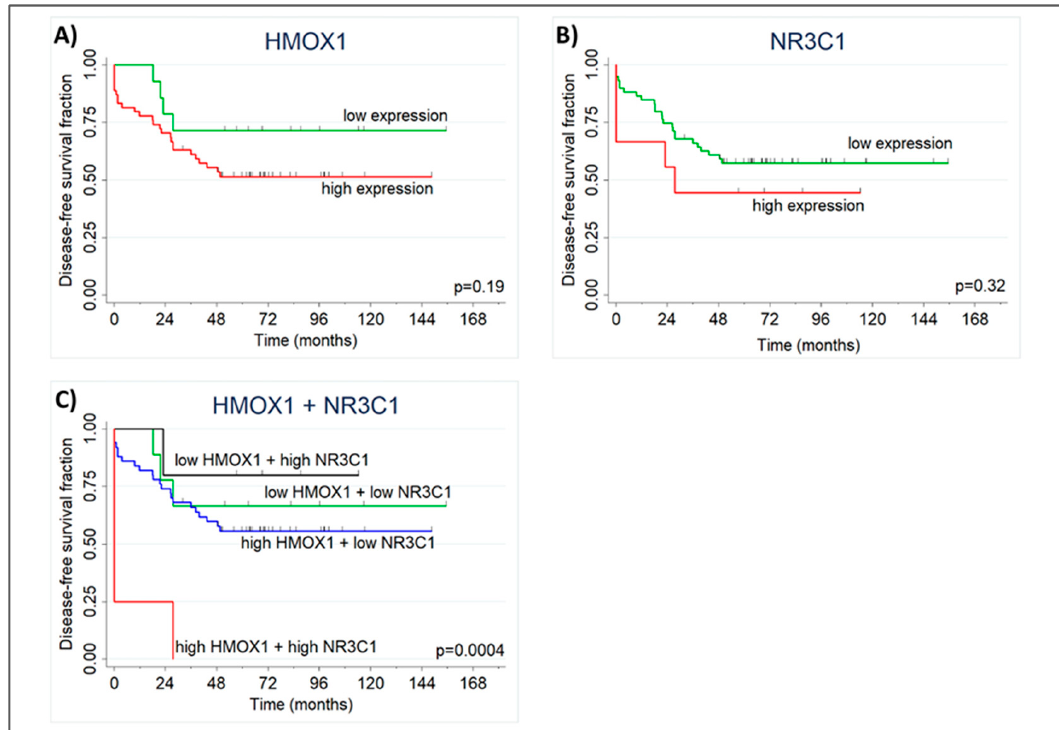
Figure 6. NR3C1 and HMOX1 high expression reduces PCa-patient disease-free survival. Kaplan Meier plot showing groups with low and high HMOX1 ( A ) and NR3C1 ( B ) expression according to ROC curve threshold. ( C ) Kaplan Meier plot showing groups with low and high HMOX1 and NR3C1 combined expression according to ROC curve threshold. Patients with high expression of both genes have shorter disease-free survival compared to other groups (log-rank p = 0.0004). Vertical marks show censored patients.